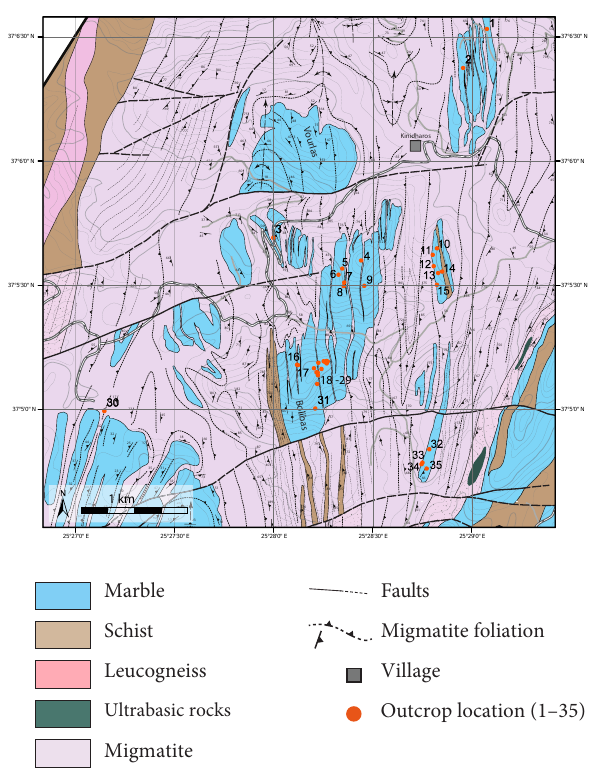
Figure 2. Geological map of the study area with outcrop locations (1–35), modified after Kruckenberg et al. (2011). Most outcrops vis- ited in this study are situated in the central high-strain zone of the migmatite